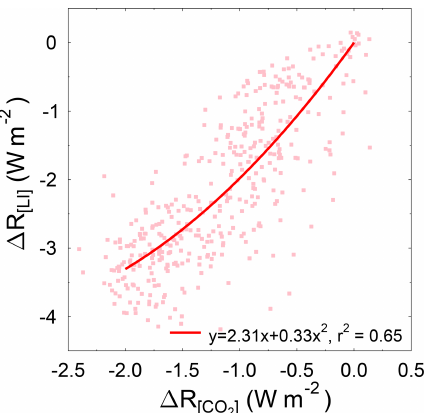
Figure 2. The relation between radiative forcing anomalies caused by CO 2 changes ( (cid:49)R [ CO ) and land ice changes ( (cid:49)R [ LI ] ) from the 2 ] whole proxy-inferred dataset (Köhler et al., 2015a) (pink dots). The red line represents a second-order polynomial least-squares regres- sion through the scattered